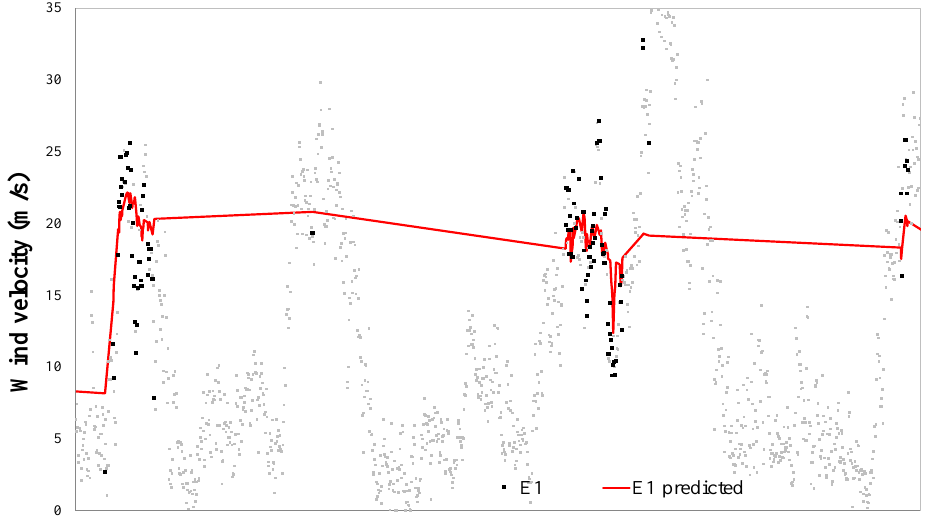
Figure 3. Curve fitting of the predicted limit speed of error 1 versus real errors.